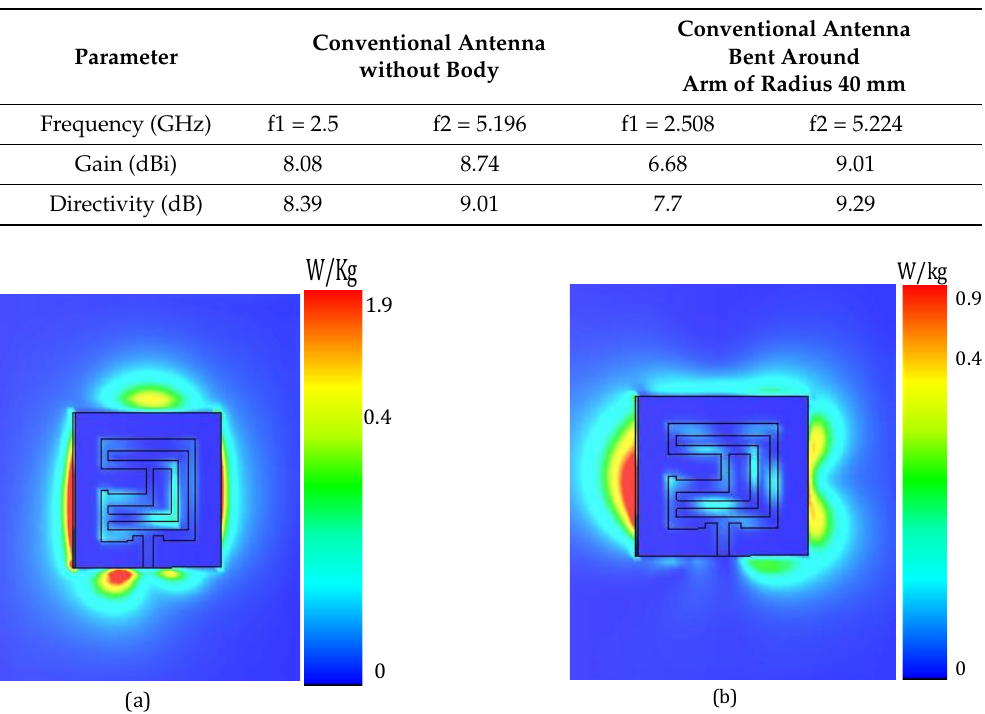
Table 5. Maximum gain and directivity comparison between conventional antenna without a body and with a child’s arm.